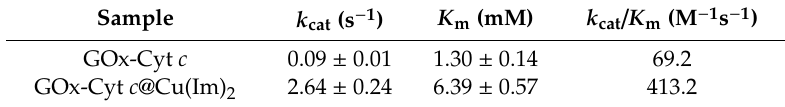
Table 3. Kinetic parameters of GOx in free GOx and Cyt c, and GOx-Cyt c @Cu(Im) 2 (mG:mC = 1). Sample